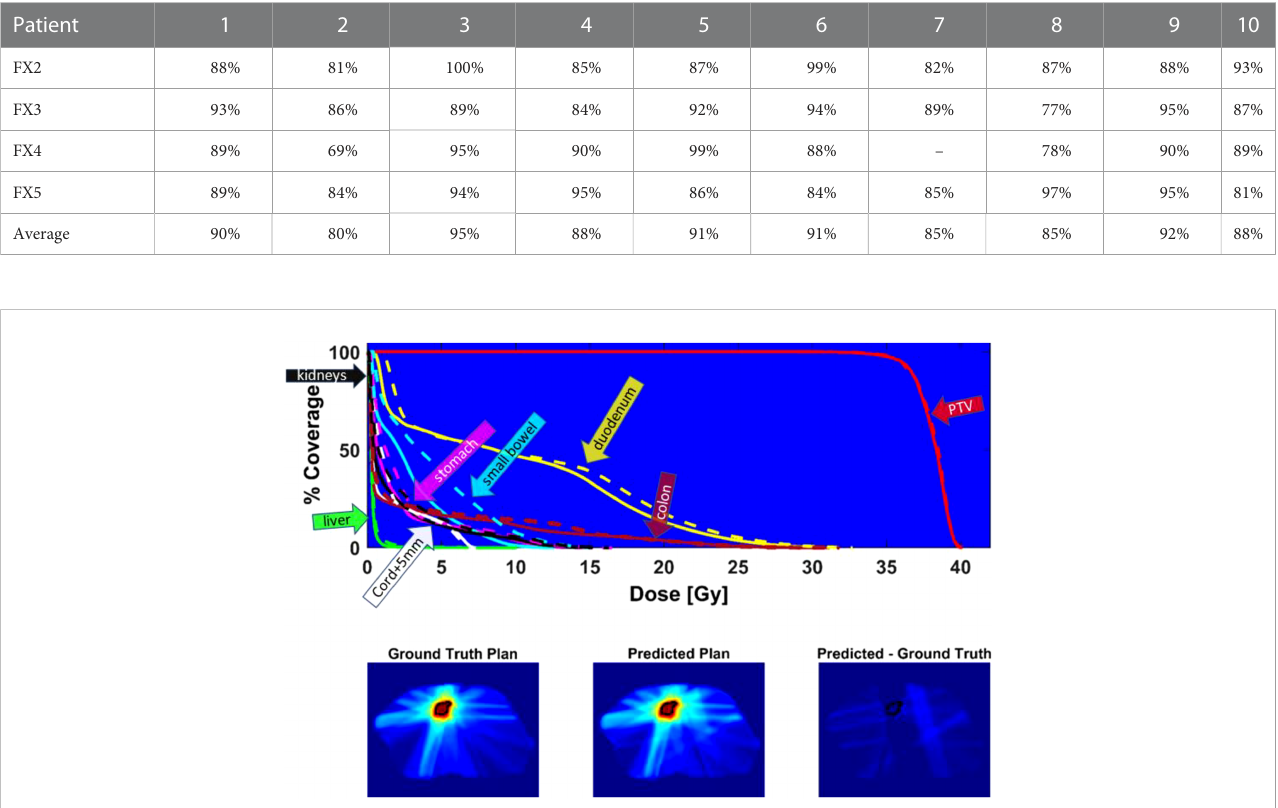
FIGURE 6 Top - DVH comparison for test case with average performance relative to Gamma passing rate: solid line = ground truth plan, dashed line = predicted plan. PTV (red), duodenum (yellow), colon (magenta), cord + 5mm (white), liver (green), small bowel (cyan), stomach (pink), kidneys (black). Bottom - center slice through ground truth dose distribution and predicted dose distribution and difference for a test case. The black contour is the PTV location.